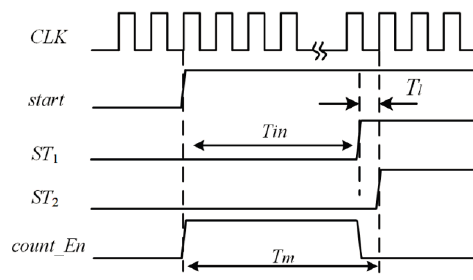
Figure 6. Block diagram of proposed TDC.